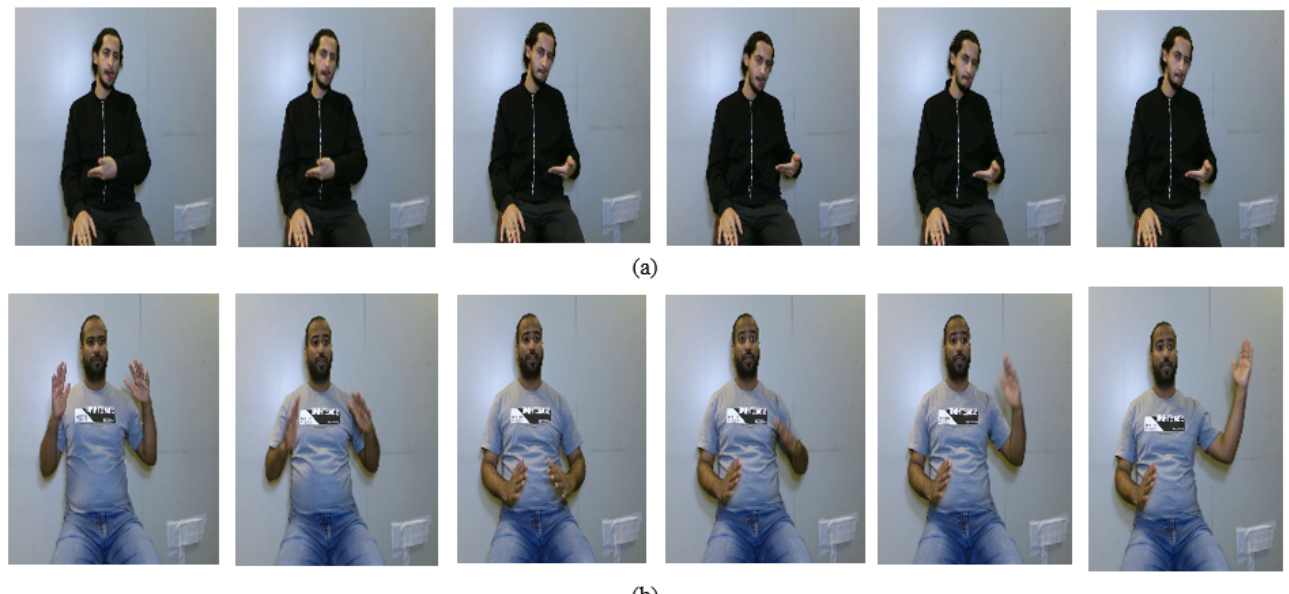
Figure 3. Selected frames of two signs of mArSL database with different number of postures: ( a ) “HUNGRY” and ( b ) “VERY SMALL”.